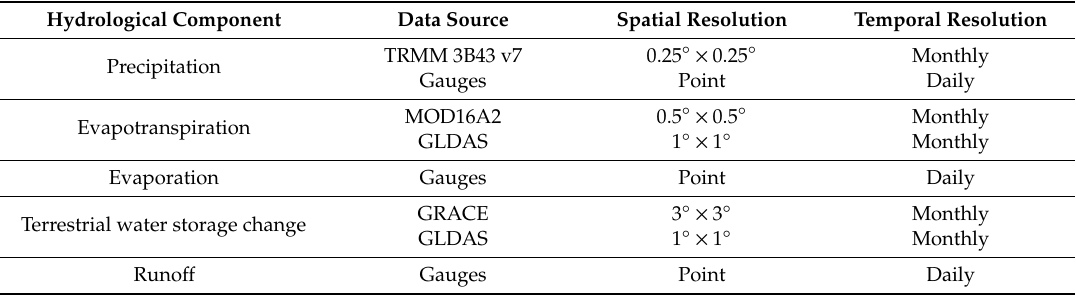
Table 1. Remotely sensed data products and in-situ gauge observations used in this study.